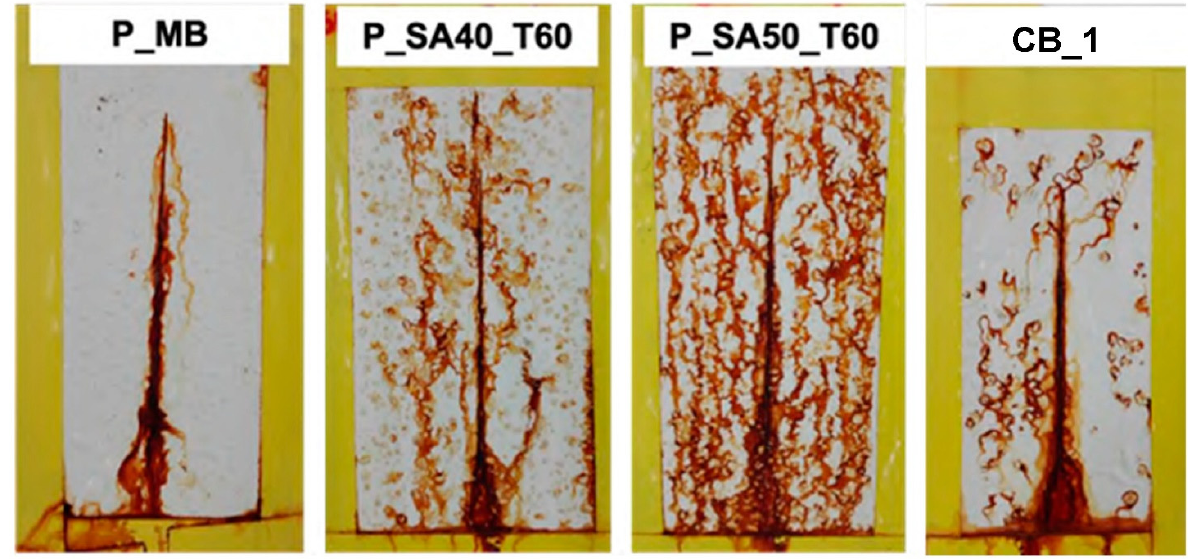
Figure 8. Results of salt spray test for scribed specimens coated with the formulated paints after 240 h of exposure to 5 wt% NaCl salty fog.